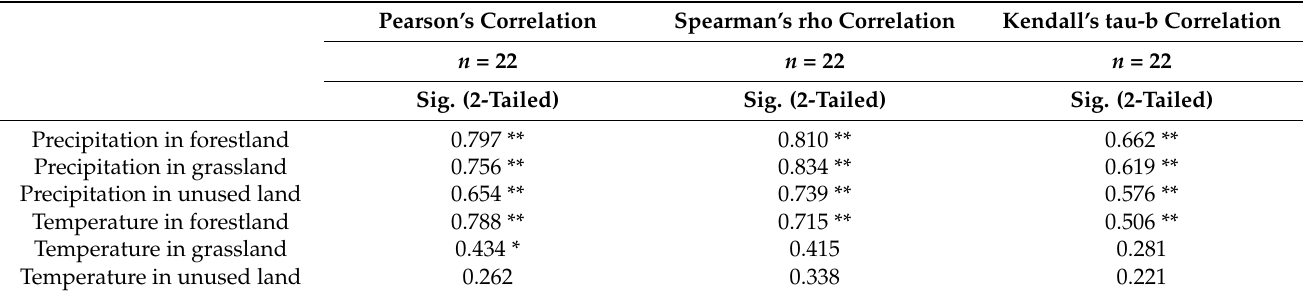
Table 2. Correlation between NPP and annual precipitation, annual temperature in the main ecosys- tems over